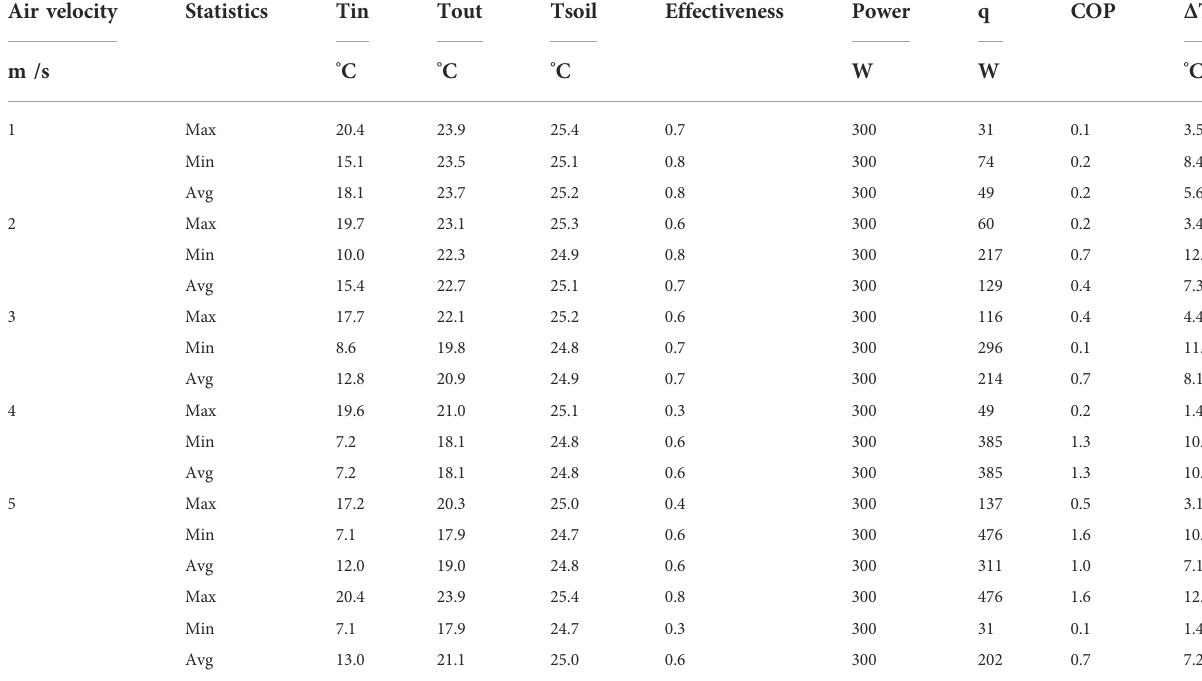
TABLE 1 Computed parameters at different experimental temperatures during